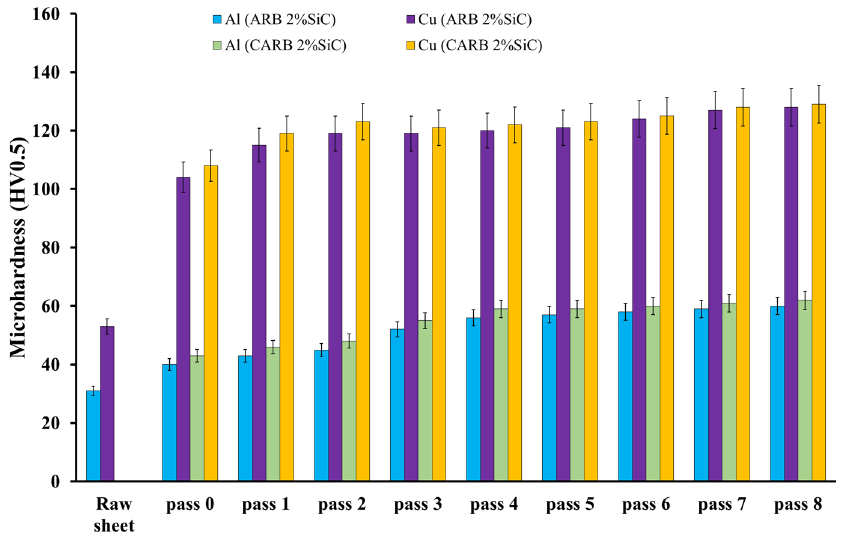
Figure 8. The variation in the hardness value of aluminum and copper layers at different passes of ARB and CARB